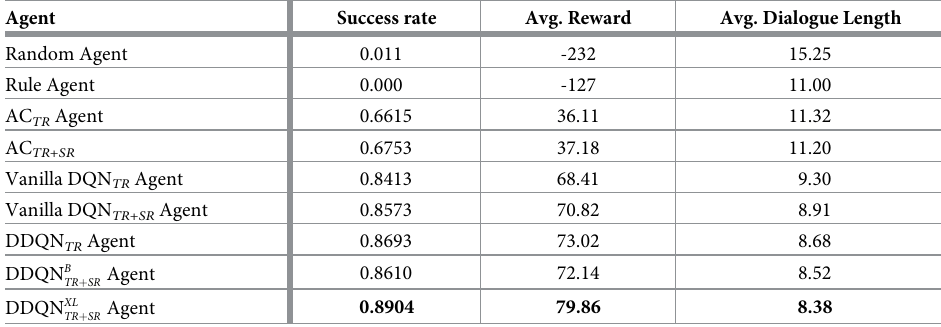
Table 7. Results obtained by different dialogue